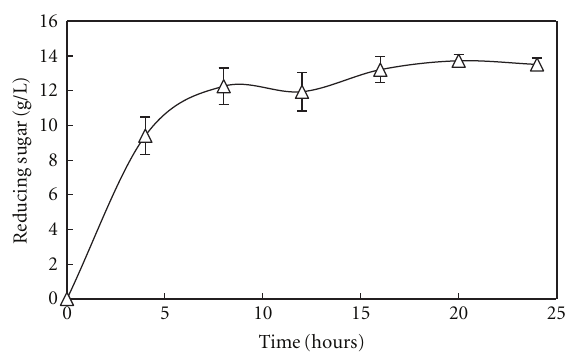
Figure 1: Time course of rice straw hydrolyzation. Reaction condition: 20g pretreated rice straw and 20 mL enzyme in 1 L volume on the shaker (150 rpm) at 50 ◦ C Error bars = mean ± standard deviation.